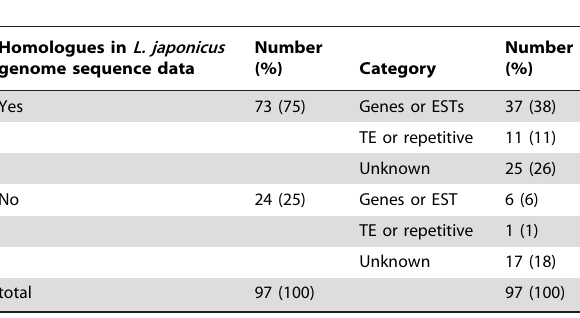
Table 2. Flanking sequences of new LORE1